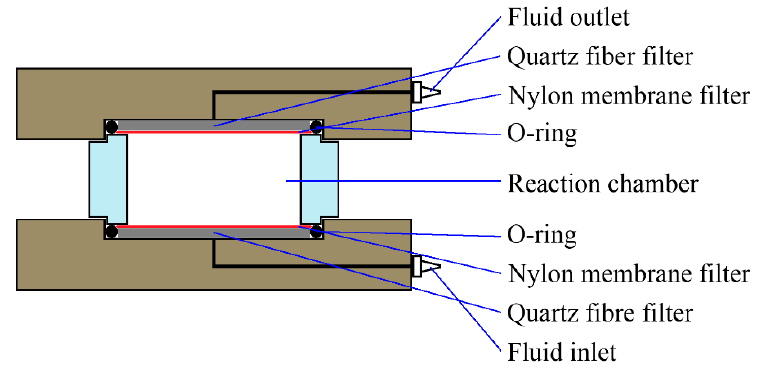
Figure 1. Schematic drawing of the flow-through cells used in this study.